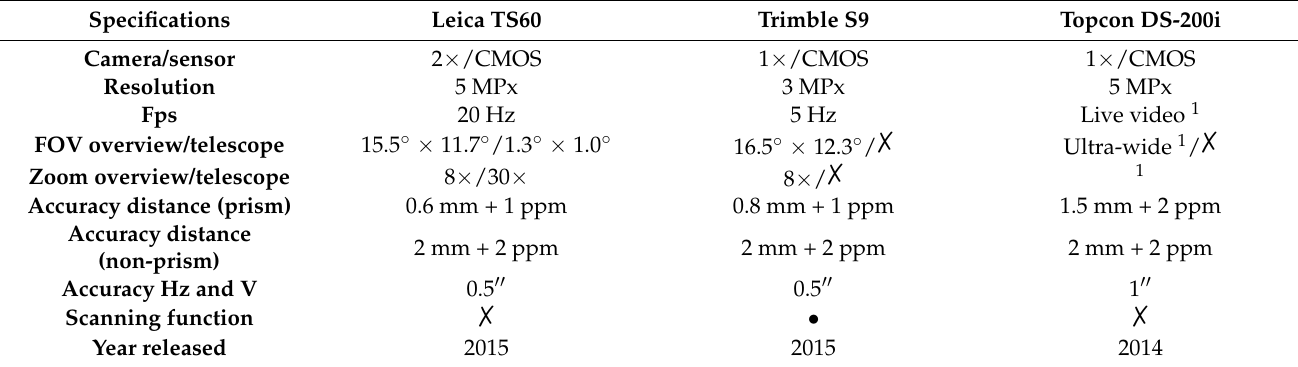
Table 1. Main specifications of currently available IATS [49–51].